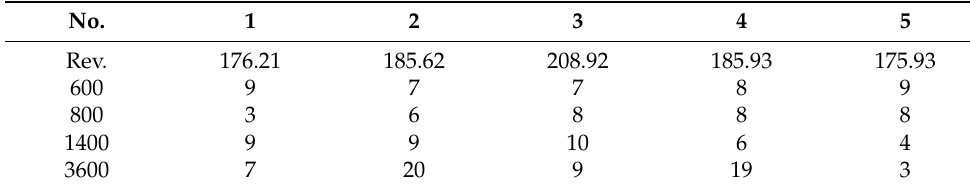
Table 11. GA revenue and bidding